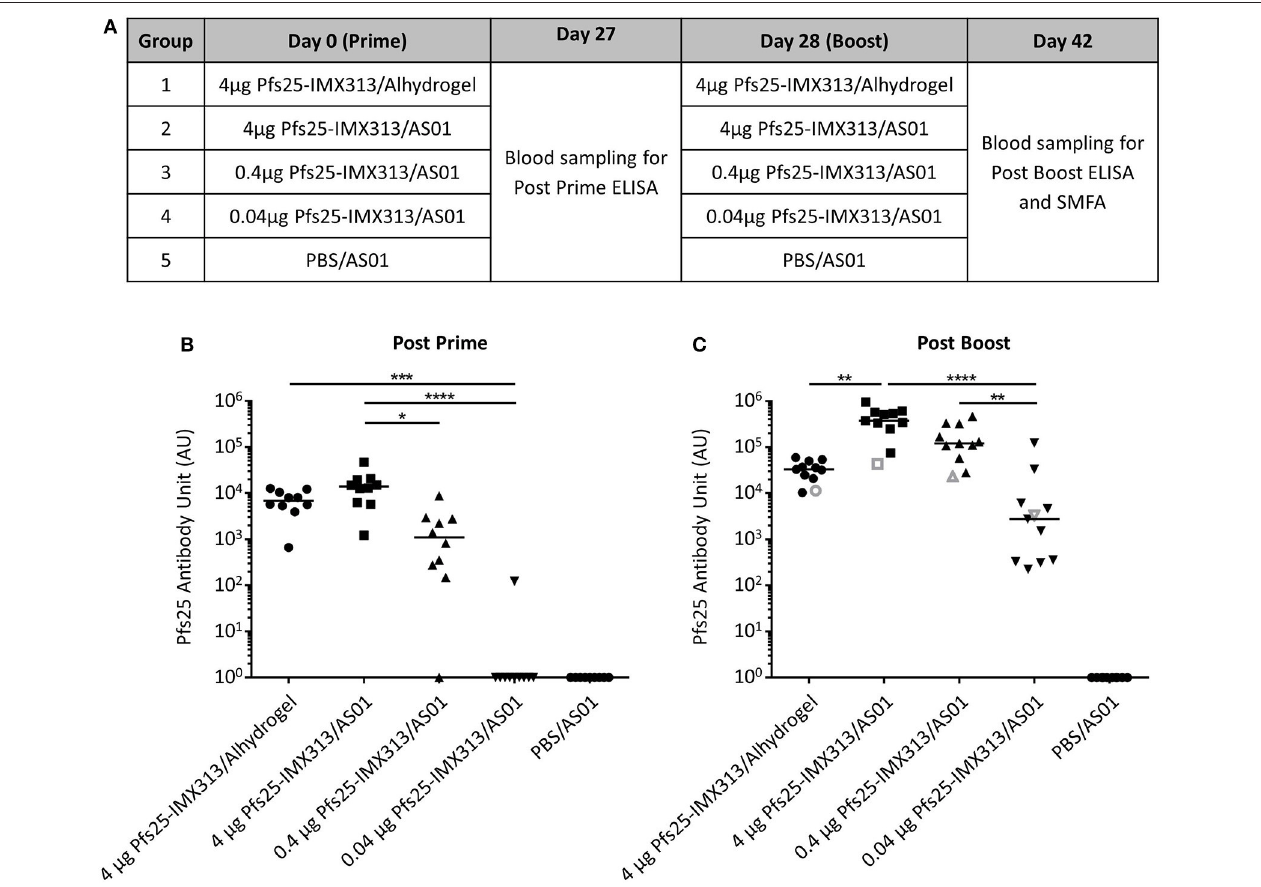
FIGURE 1 | Immunogenicity of Pfs25-IMX313 in AlhydrogelFigure or AS01. (A) CD1 mice ( n = 10) were vaccinated twice with 4 µ g Pfs25-IMX313 in Alhydrogel or with decreasing doses (4 µ g, 0.4 µ g and 0.04 µ g) of Pfs25-IMX313 in AS01. BC Anti-Pfs25 IgG titres were measured by ELISA at 4 weeks post prime (B) and 2 weeks post boost (C) . Empty gray shapes show the antibody units of a 1 mg/ml dilution of purified IgG. Data points show antibody titres in individual mice, lines show the median. * p ≤ 0.05, ** p ≤ 0.005, *** p ≤ 0.001, **** p ≤ 0.0001, Dunn’s multiple comparison